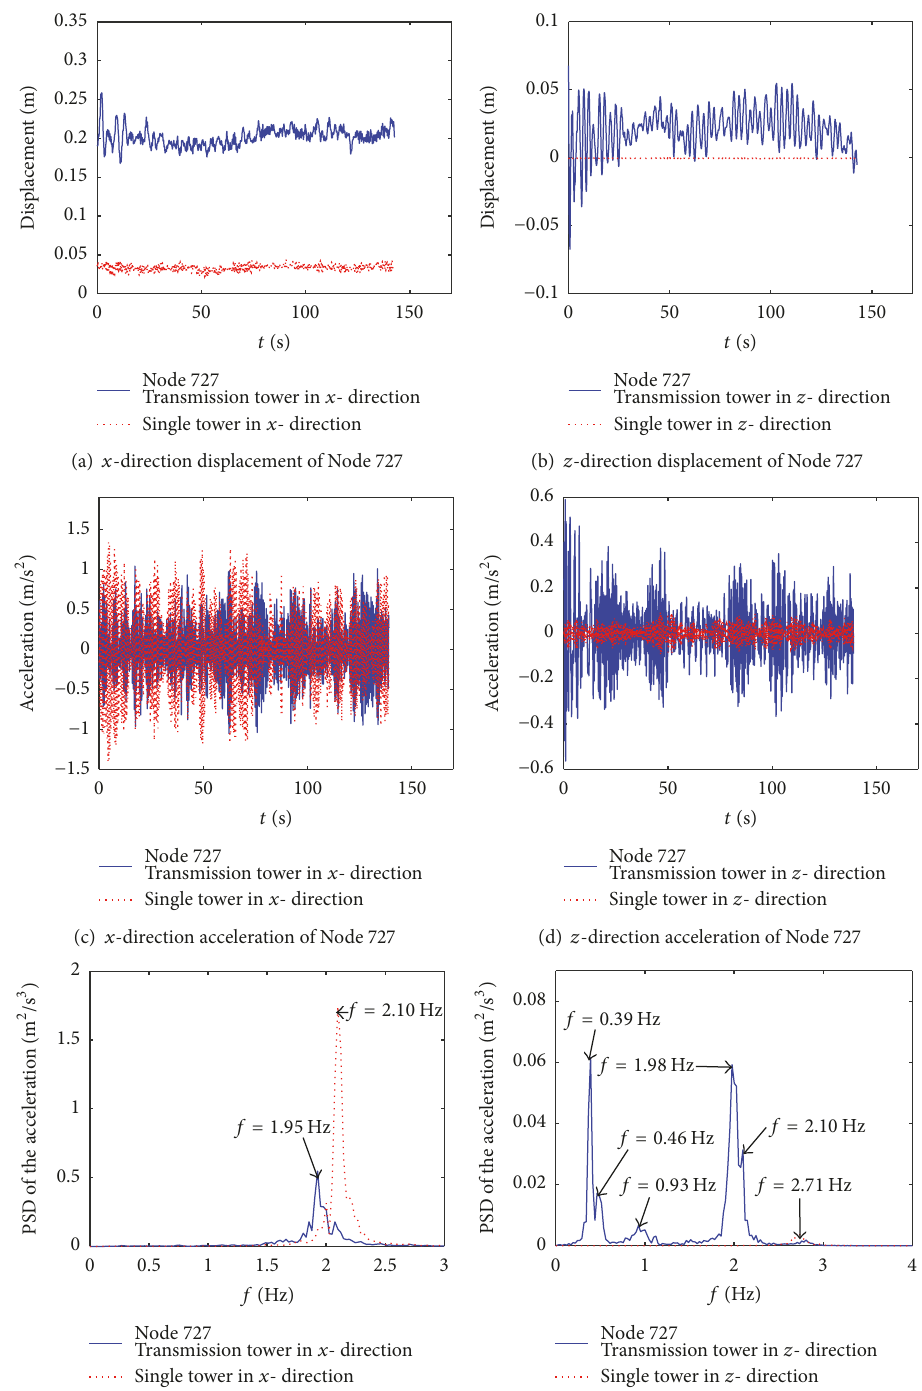
Figure 20: Steady-state response of Node 727 of the tower under the design wind speed ( 𝑈 10 = 25.3